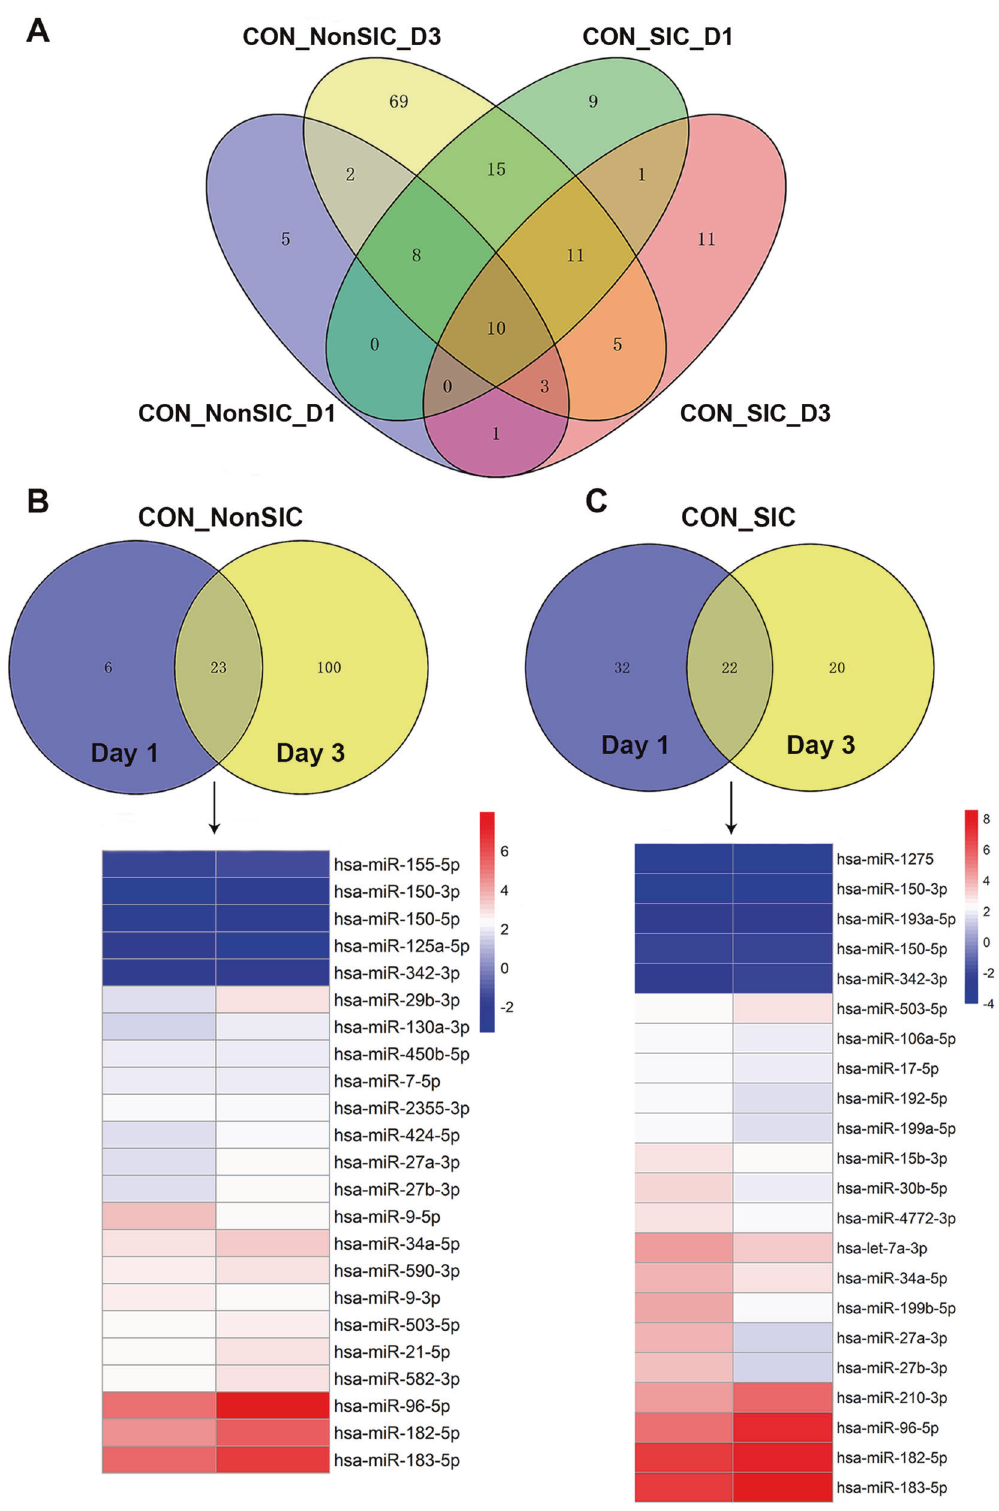
Fig. 1 RNA analysis of neutrophil-derived EVs from different participants. A Venn diagram illustrating the number of miRNAs from patients with SIC and with non-SIC at ICU admission (D1) and after 3 days (D3) as compared with those of healthy volunteers. B The heatmap indicates the fold change pro fi le of the 23 miRNAs differentially expressed at both time points of the non-SIC group versus control subjects. C The heatmap indicating the fold change pro fi le of the 22 miRNAs differentially expressed at both time points of the SIC group versus control